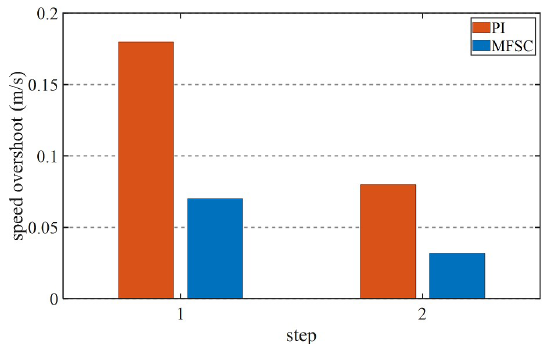
Figure 16. Speed waveform of sudden load in MFSC